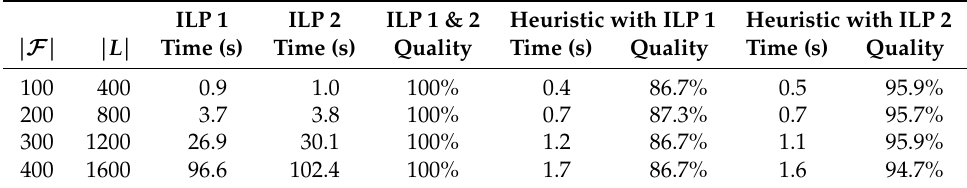
Table 1. Experimental results for instances with different numbers of points but a constant spatial density of one point per area unit. Four rectangles of size 1.0 × 0.5 were generated for each point. Every square of size 1 × 1 was required to intersect at most two labels. Running times are in seconds CPU time. Every value is the average over ten instances.